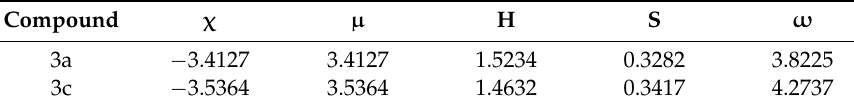
Table 6. Calculated reactivity descriptors (in eV) for the studied compound.